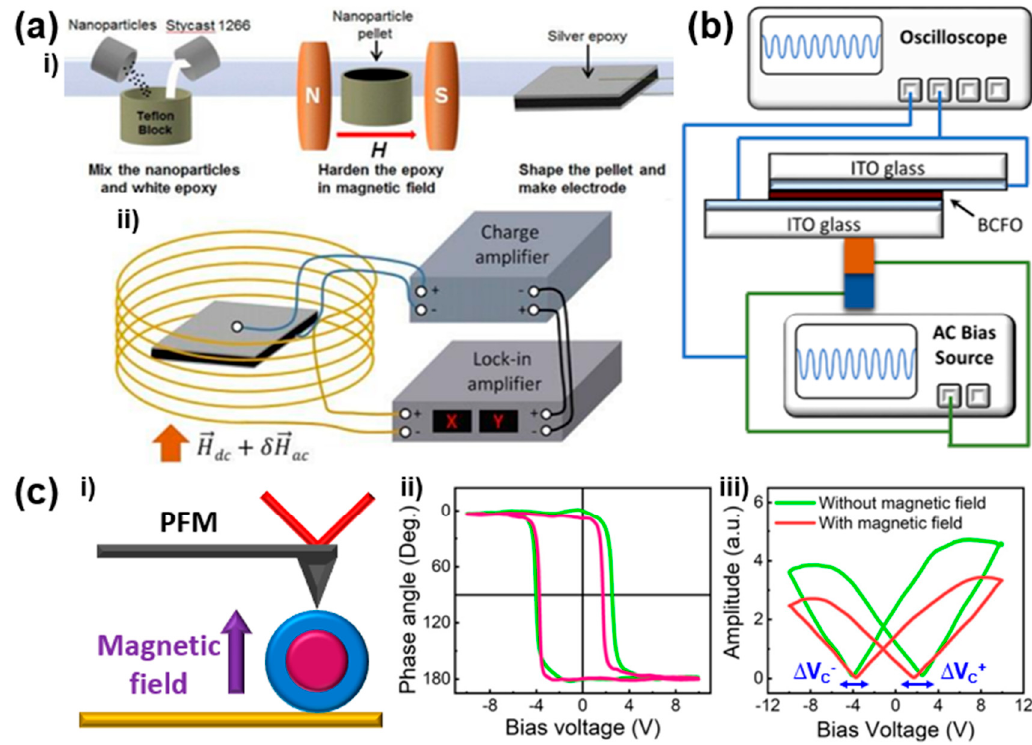
Figure 4. Schematics showing different ME measurement methods of MENPs. ( a )-(i) Fabrication process of bulk ME composites consisting of MENPs embedded in a polymer matrix, and (ii) dynamic ME measurement setup. Reproduced with permission from [75]. Copyright 2016, American Chemical Society. ( b ) ME characterization of multiple MENPs placed between two electrodes con- nected to the oscilloscope under an AC magnetic field. Reproduced with permission from [59]. Cop- yright 2022, Science. ( c )-(i) Piezoresponse force microscopy (PFM) probe system for ME measure- ment of a single MENP, (ii) hysteresis and (iii) bipolar strain vs. electric field (S-E) curves obtained from a single MENP with and without the application of a magnetic field, which is utilized for the calculation of the ME voltage coefficient. Reproduced with permission from [45]. Copyright 2022, Royal Society of Chemistry. To overcome the limitations of ME measurements for bulk specimens containing MENPs, multiple MENPs were placed between two electrodes, which were connected to an oscilloscope (Figure 4b) [59]. Under a low-frequency alternating magnetic field, MENP- induced response was detected, exhibiting similar waveforms to the applied magnetic field intensity and confirming that the voltage signals resulted from the ME phenomenon activated by the magnetic field. Using this method, amplified voltage signals of MENPs can be obtained with no polarization reduction due to charge leakage and structural change of the material [76]. However, it is insufficient to determine the exact ME voltage coefficient of a single MENP, because it does not consider errors caused by the size devi- ation of the manufactured MENPs and the generation of large granulated secondary par- ticles by primary particle aggregation. Precise ME measurements of a single MENP are still challenging because of the small size of the particles. Recently, the modified piezoresponse force microscopy (PFM) probe system for the point I-V method was utilized to directly measure the ME voltage coeffi- cient of a single MENP, as illustrated in Figure 4c(i) [45,59,63]. The ME measurement using a modified PFM probe system is based on the converse piezoelectric effect, which transfers the applied electricity into strain by ME coupling. During the PFM measurement, the di- rections of the MENP polarization, which switch under the applied electric field, were compared with the piezoresponse hysteresis loops with and without an external magnetic